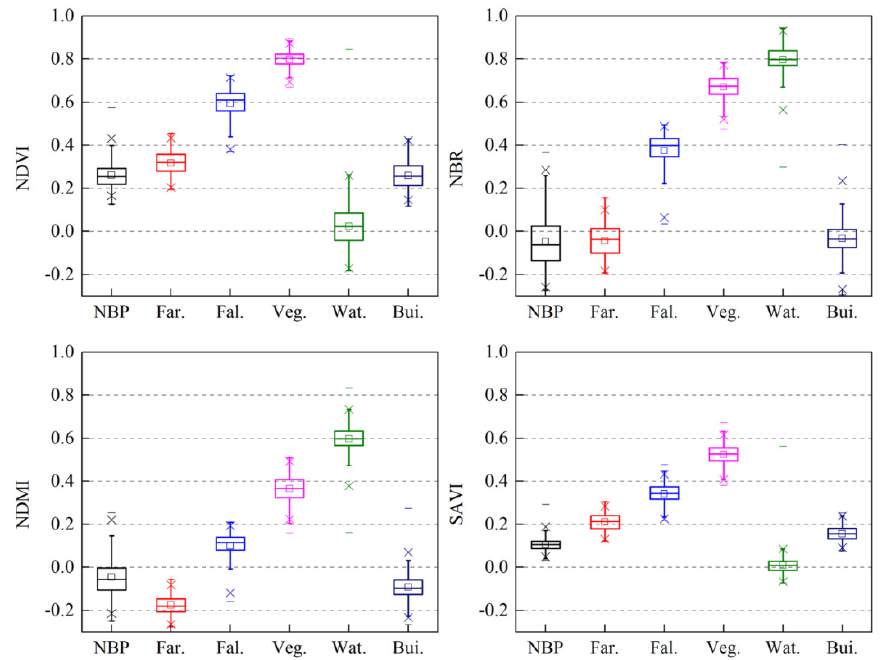
Figure 4. Differences of OLI-derived NDVI, Normalized Difference Moisture Index (NDMI), the Normalized Burn Ratio (NBR) and Soil Adjusted Vegetation Index (SAVI) for sampling points of swidden agriculture and other various land-cover types. NBP, newly-burned plots; Far., farmlands; Fal., fallows; Veg., vegetation; Wat., waterbody and Bui., built-up land.